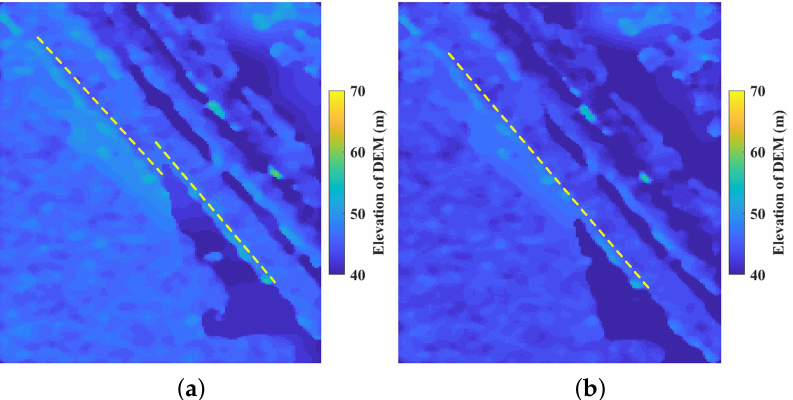
Figure 15. Enlarged view ( a ) before and ( b ) after adjustment of railway area. The dotted lines indicate the locations of the